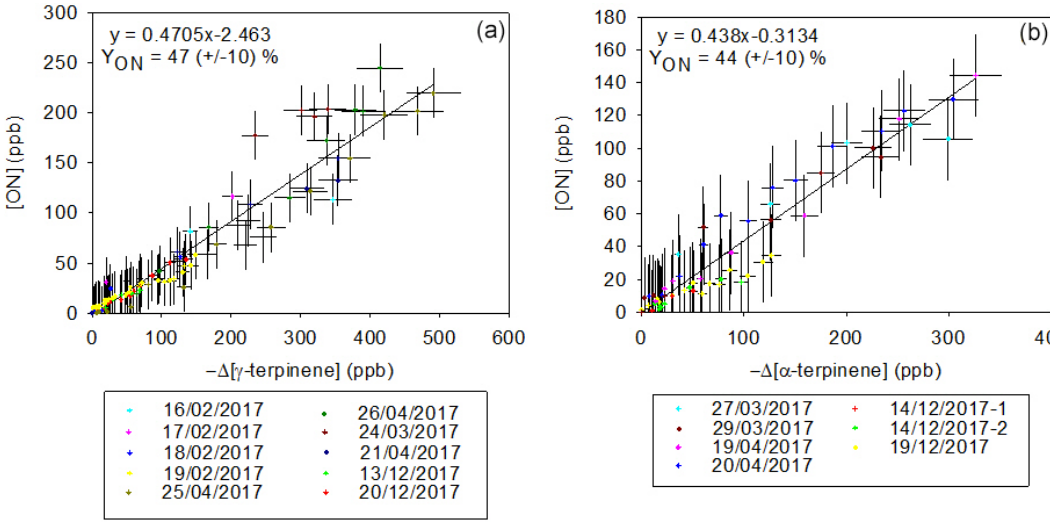
Figure 6. Gas-phase organic nitrate production vs. loss of γ -terpinene (a) and α -terpinene (b)